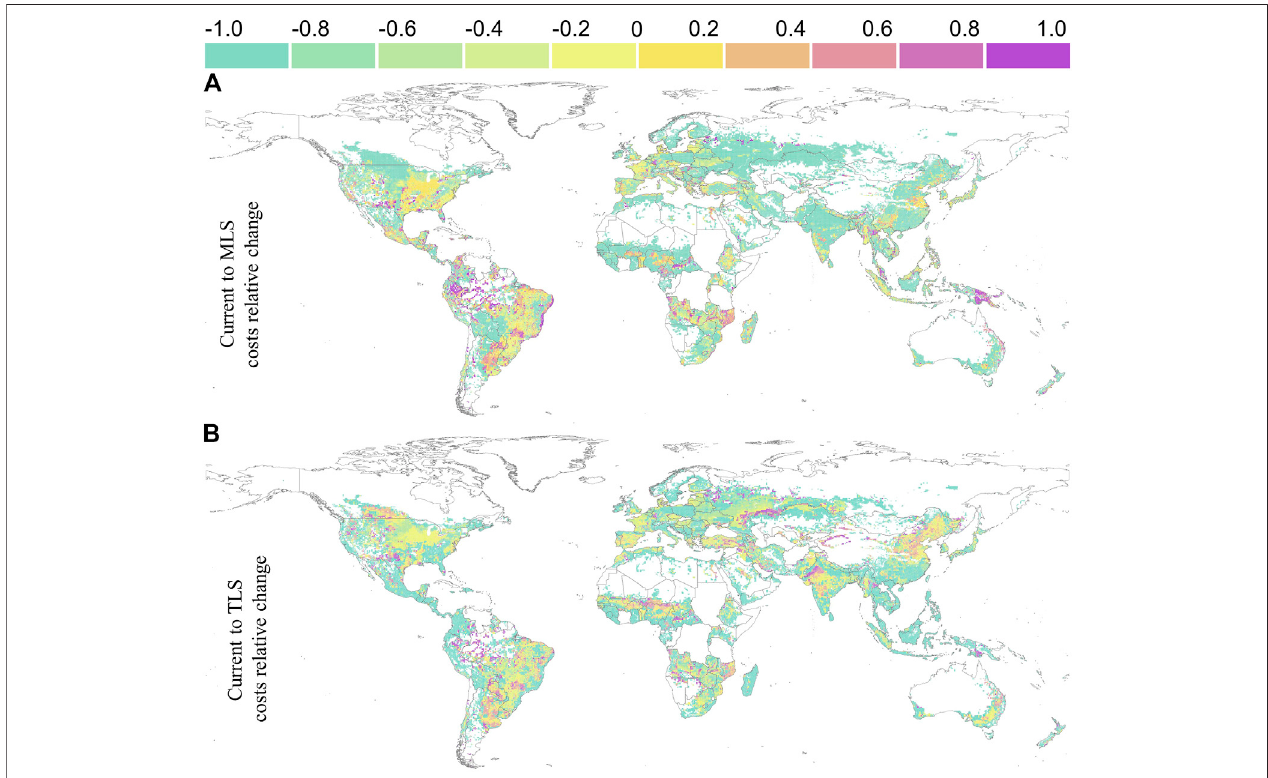
FIGURE 4 | Relative change in total costs of agricultural production for the ten major crops. (A) . Relative change in costs between current production costs and costs under the maximum land sparing production scenario (MLS) (B) . Relative change in costs between current production costs and costs under sparing of at least 20% of cropland in each simulation unit and entirely abandoning biodiversity hotspots